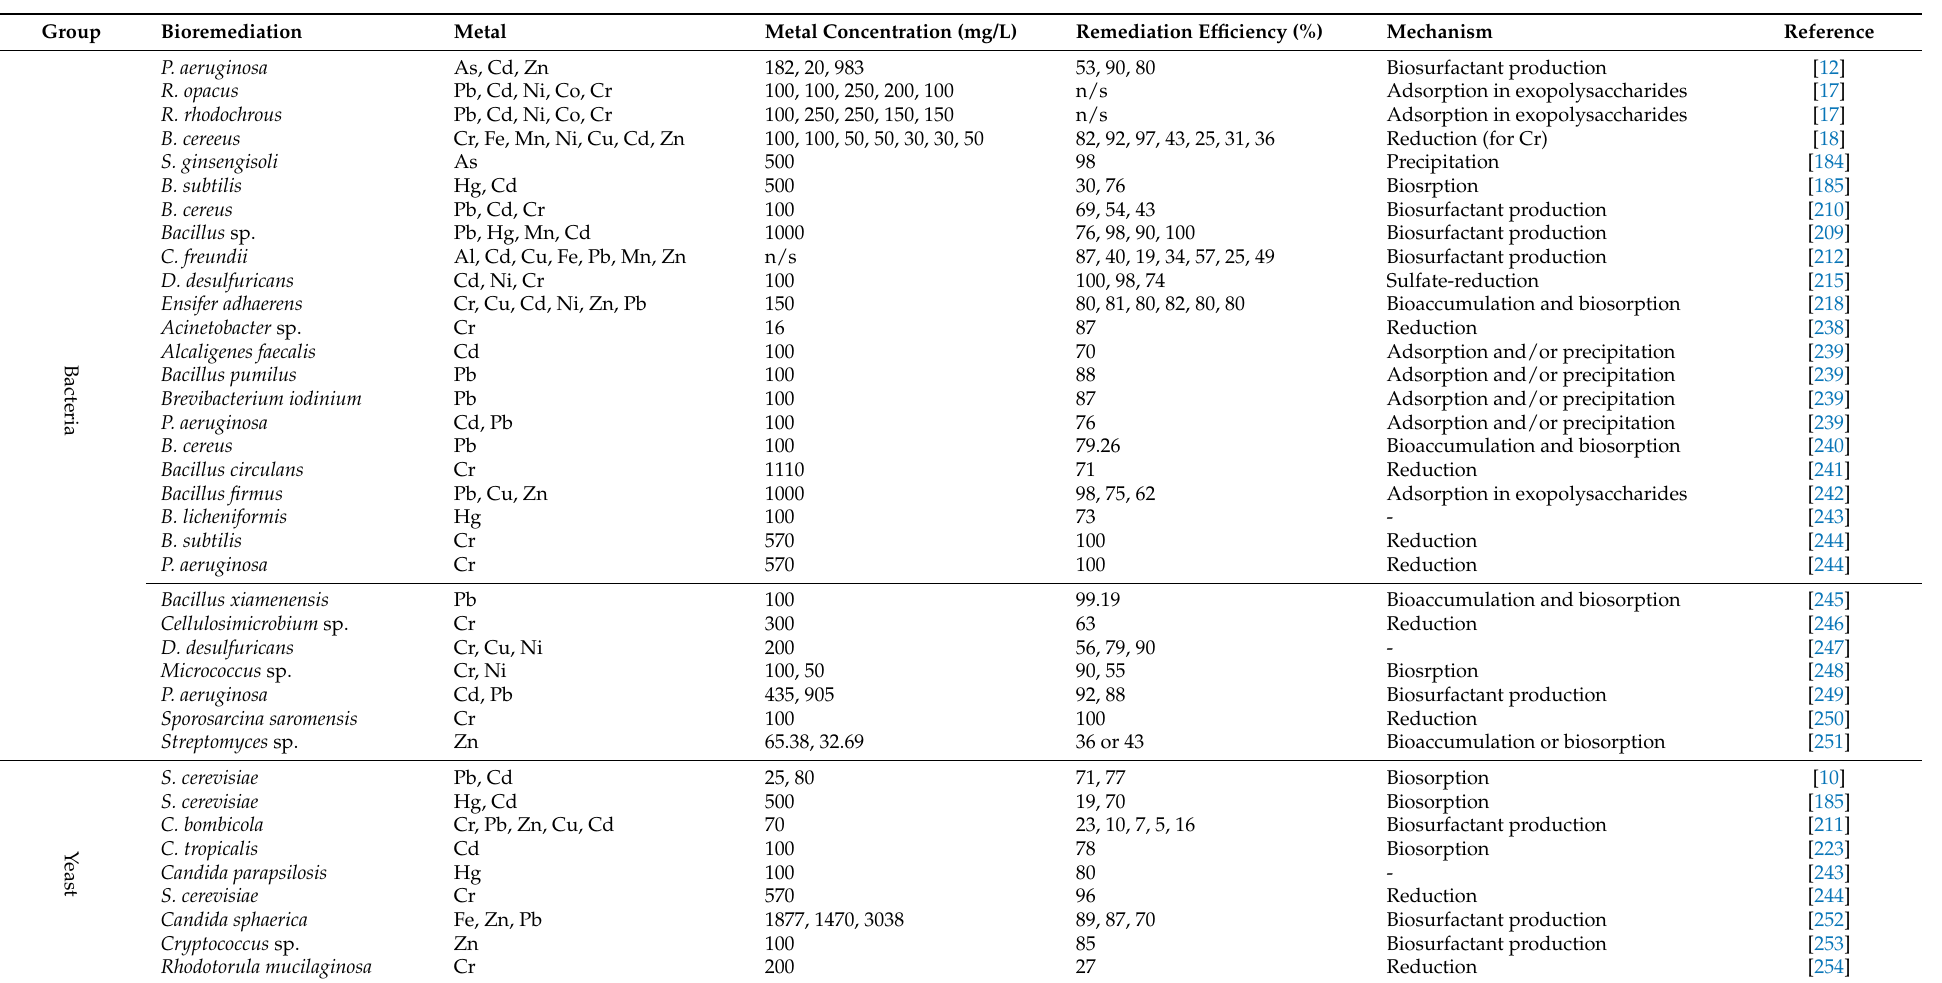
Table 3. List of some microorganisms used for microbial